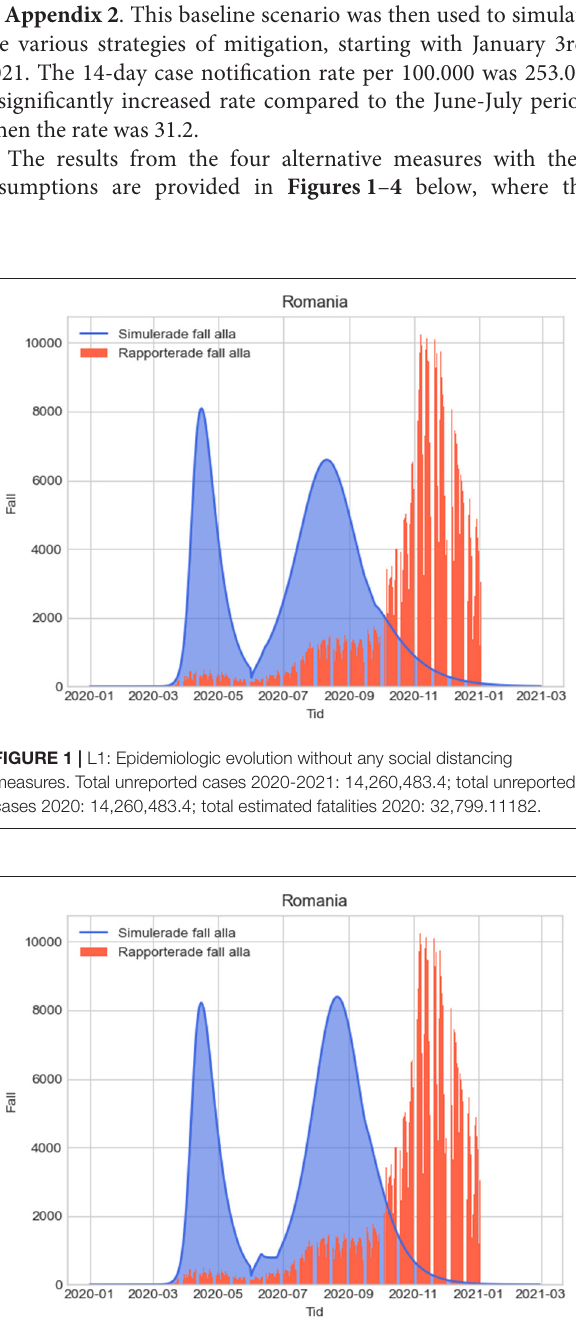
FIGURE 4 | L4: Epidemiologic evolution with suppression for 2 months. Total unreported cases 2020-2021: 13,490,259.84; total unreported cases